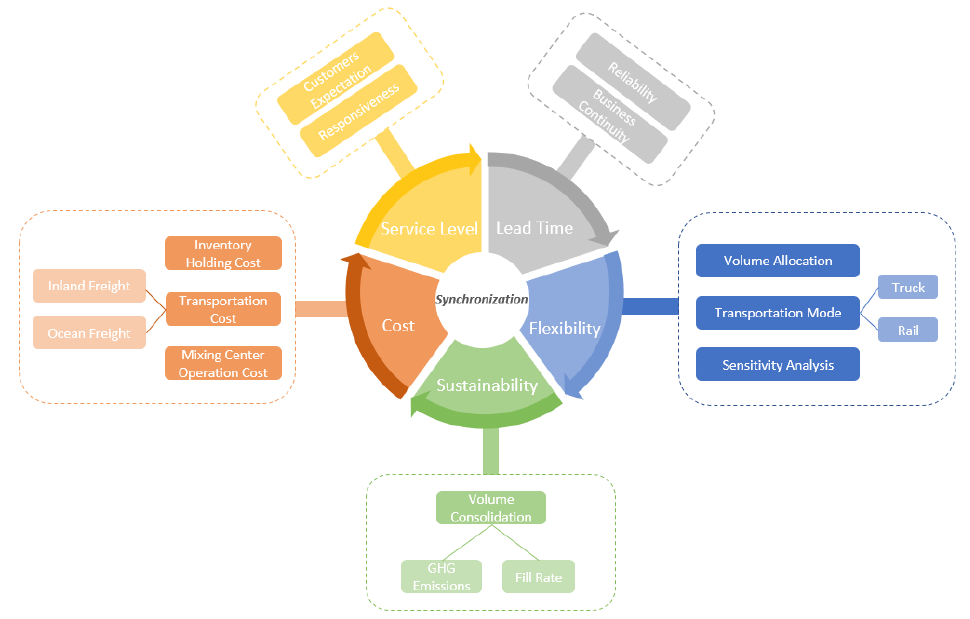
Figure 6. Framework for synchromodal supply chains.